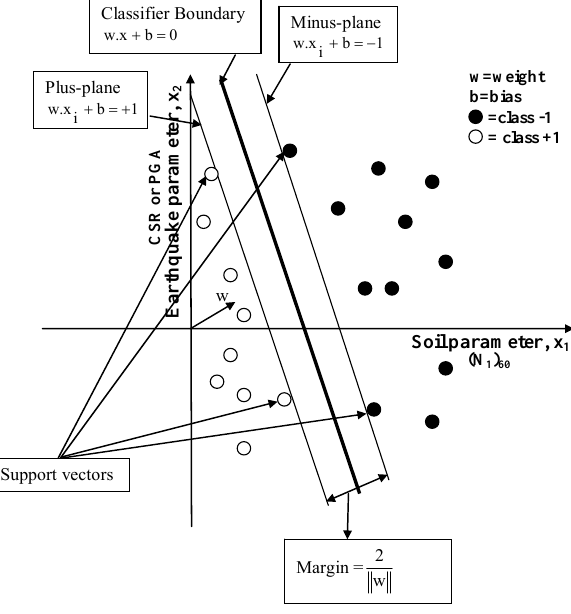
Figure 1. Support vectors with maximum margin. Fig. 1. Support vectors with maximum